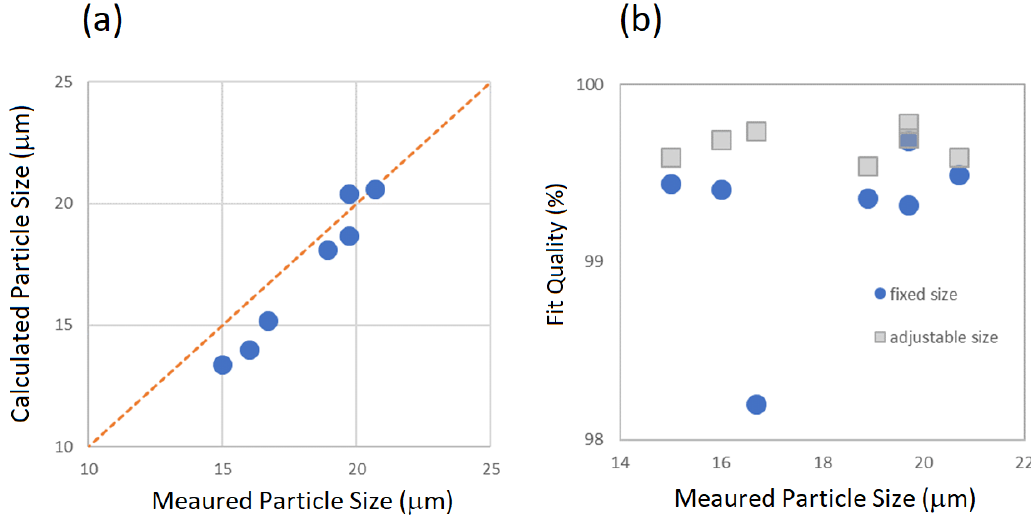
Figure 6. Selected results of the second fitting procedure, the particle size is taken as an adjustable fitting parameter, as applied to the same compression test data as shown in Figure 5, for Inconel 718 particles #1–4 (Table 1). The dotted lines are the converted measured data and the solid lines (50% transparent, red in the colour version) are the fitting curves.